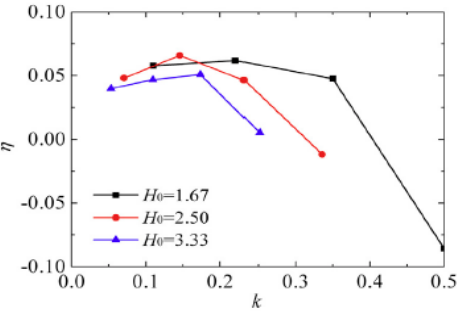
Figure 5. Variation of efficiency ( η ) vs reduced frequency ( k ) for a flapping airfoil blade with H 0 [80].